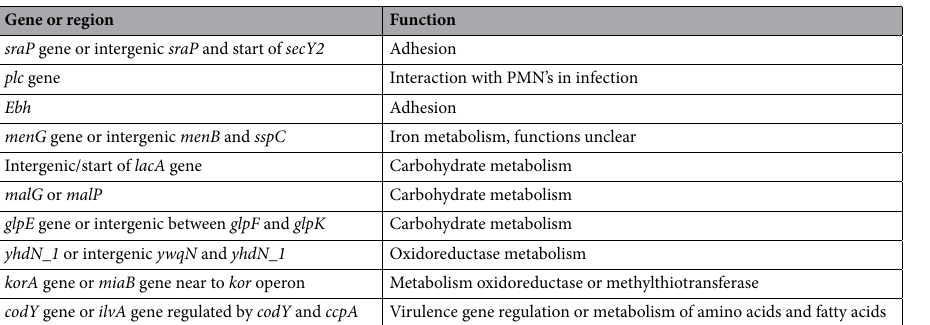
Table 2. Genes or regions corresponding to unitigs present in all S. aureus isolates from bats and in no other host isolates in both ST1 and ST3926 (CC188) with the function (where known).